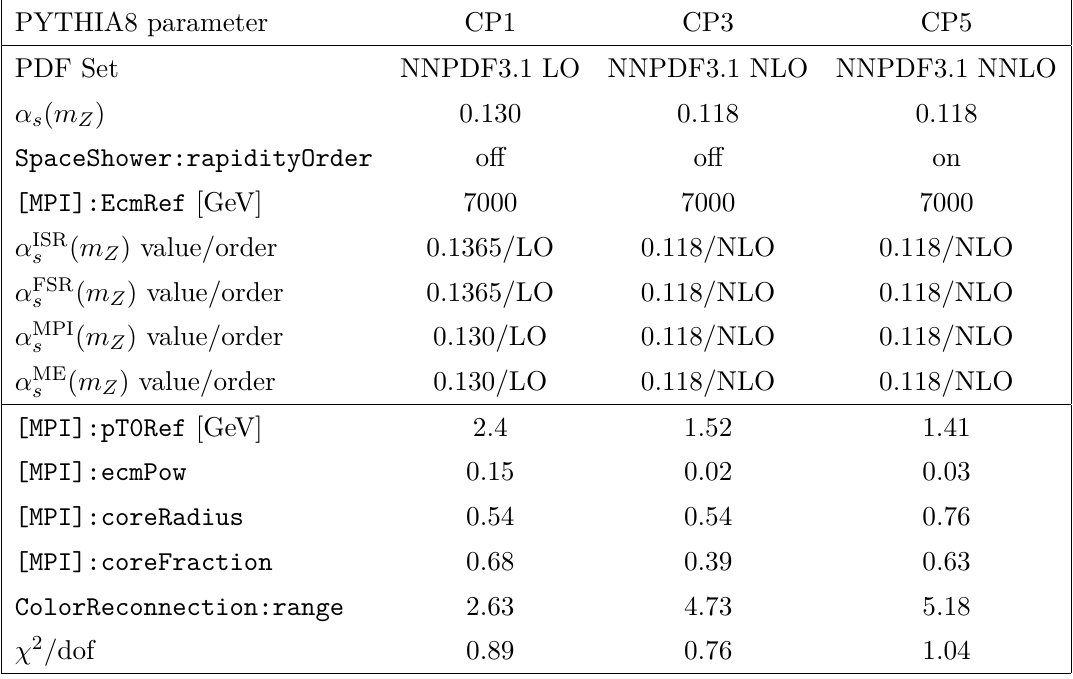
Table 1 . PYTHIA8 tunes by the CMS collaboration [45]. These tunes use the Schuler-Sjöstrand diffraction model [46] and also include the simulation of central-diffractive (CD) processes. The number of degrees of freedom (dof) is